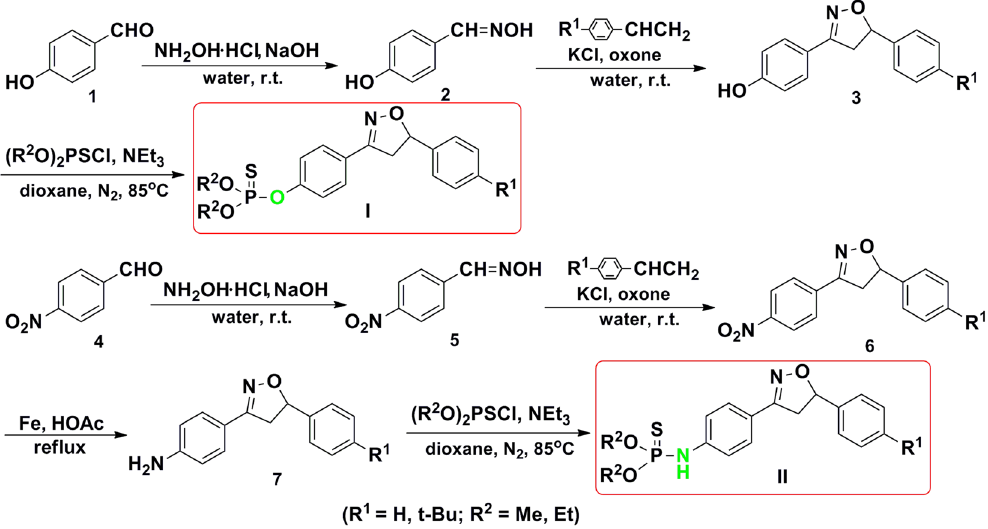
Figure 1. Procedures for Synthesis of Target Compounds I and